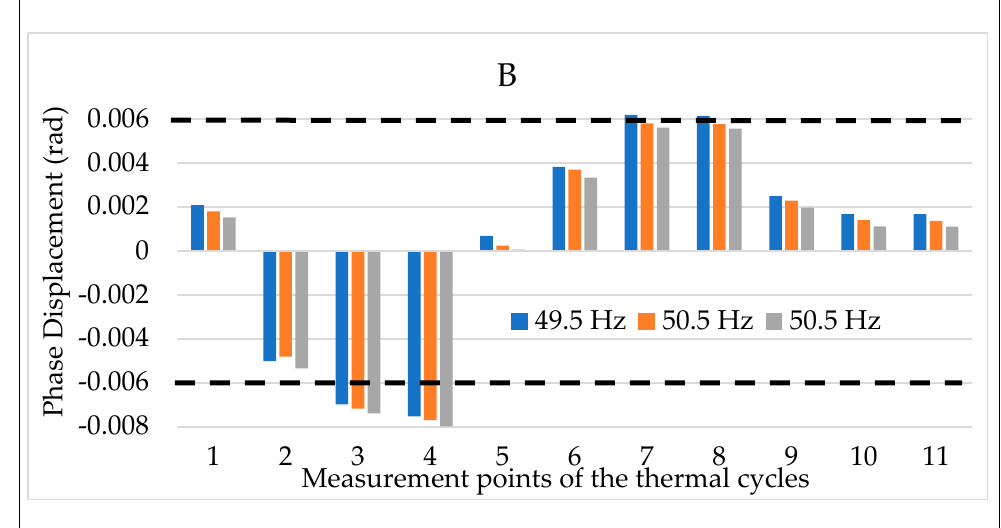
Figure 20. Phase displacement vs. temperature + frequency for LPVT B.